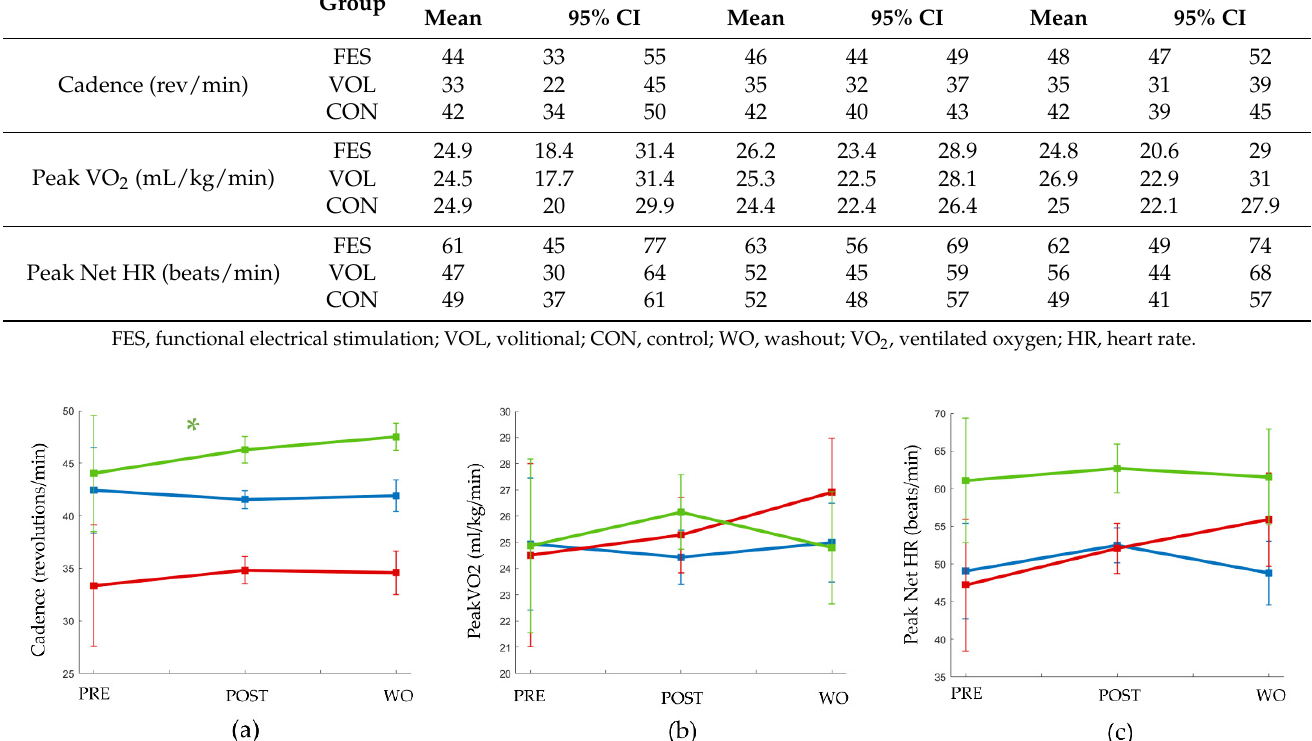
Table 3. Means and 95% confidence intervals at PRE, POST, and WO for cadence, peak VO 2, and peak net HR. PRE POST WO Group Mean 95% CI CON